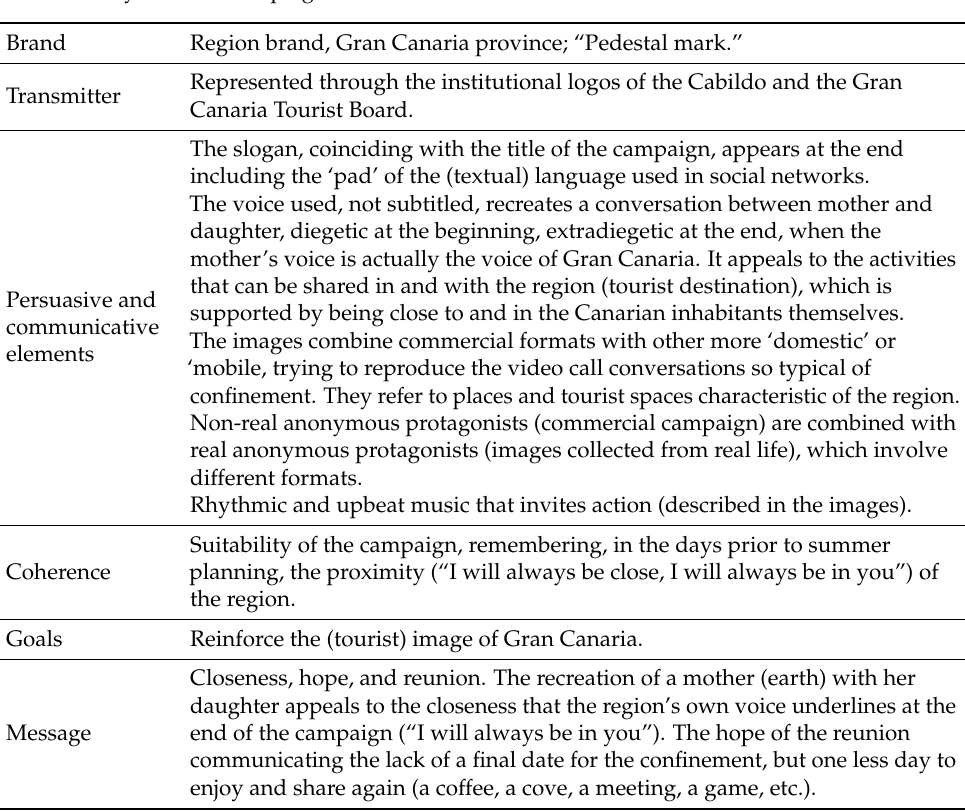
Table 4. Analysis of the campaign “#Much to